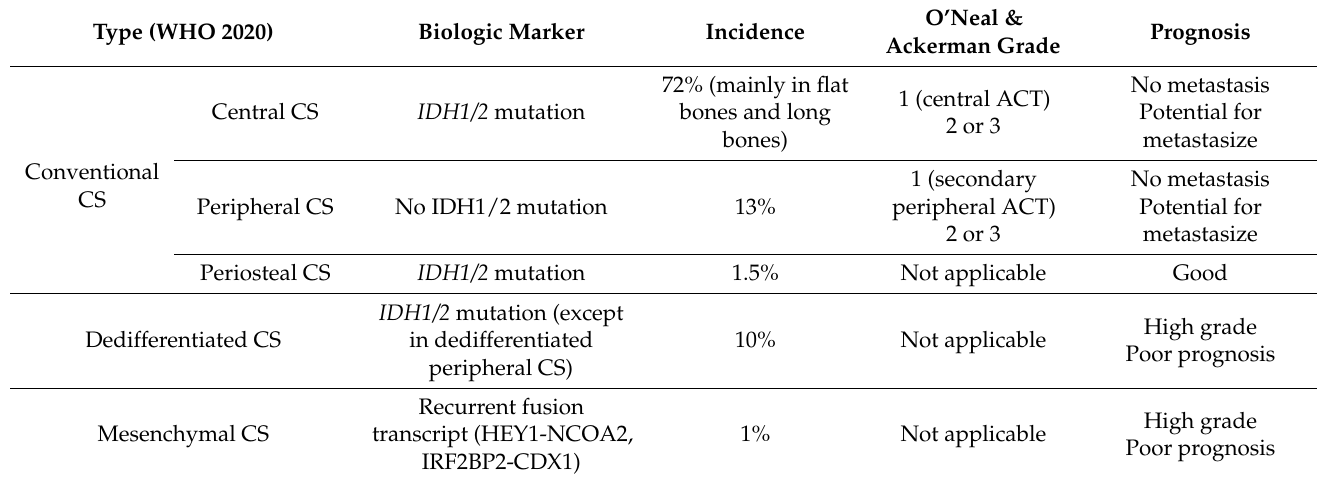
Table 1. Chondrosarcoma histological subtypes. We excluded clear cell chondrosarcomas (CS) which represent around 2.5% of all